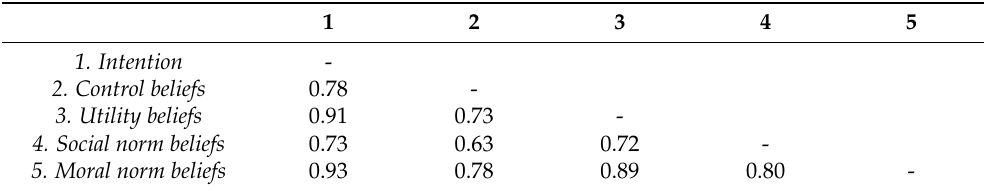
Table 7. Heterotrait-monotrait ratio of correlations for Study